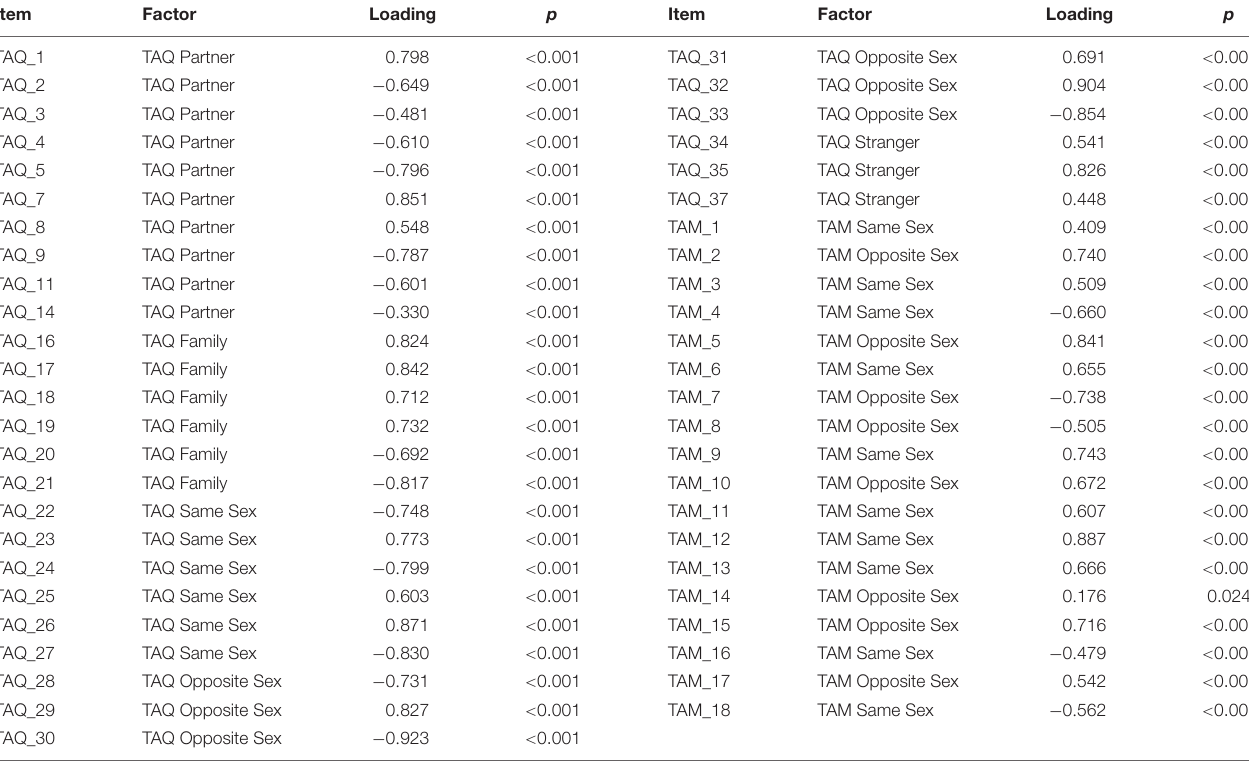
TABLE 2 | Factor loadings for the Touch Avoidance Measure (TAM) and Touch Avoidance Questionnaire (TAQ). Item Loading